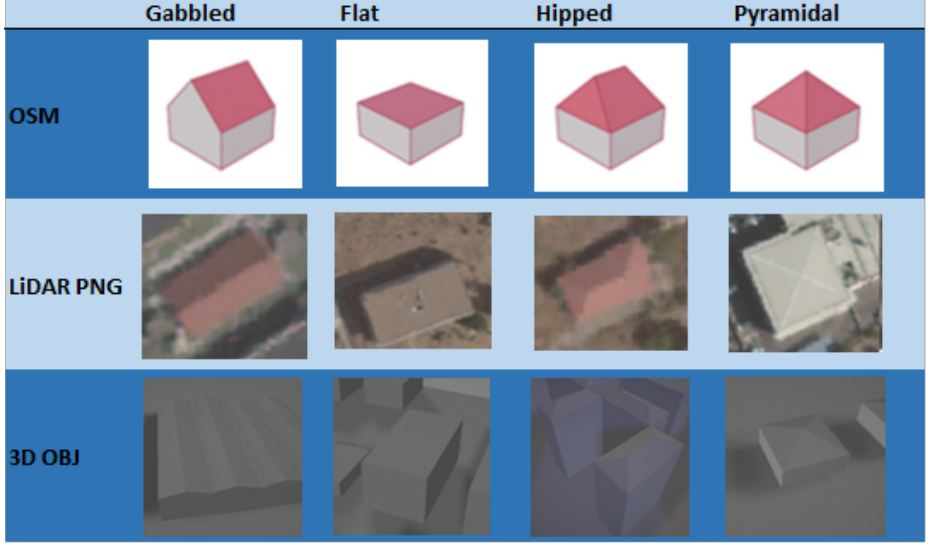
Figure 5. Comparison of different roof